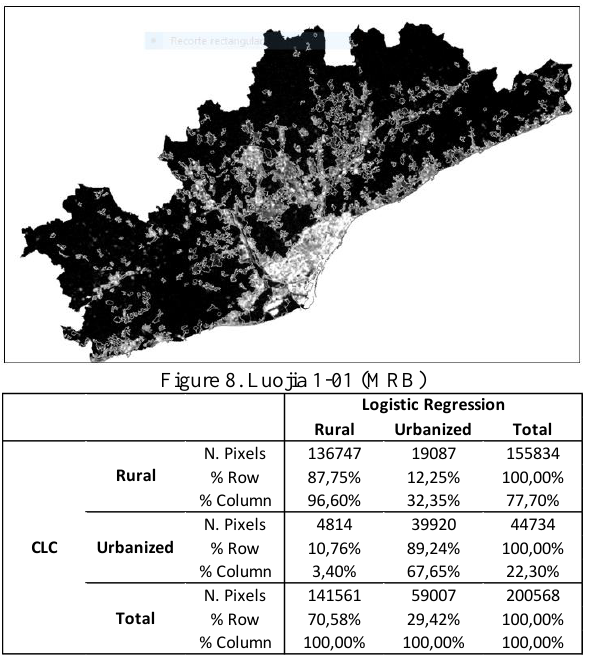
Table 3. Urbanized Land (CLC) vs Luojia 1-01 (MRB)